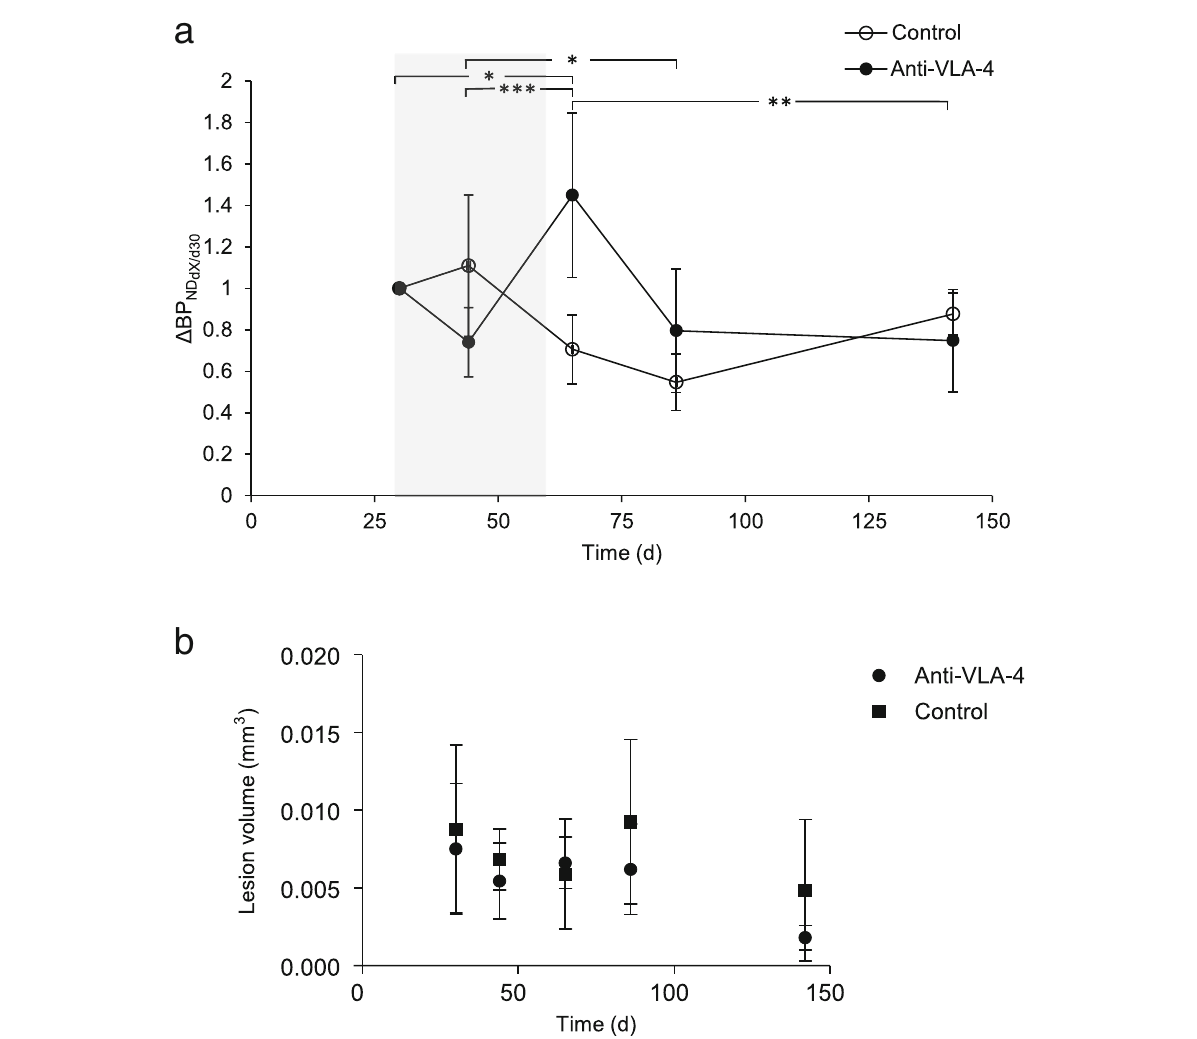
Fig. 3 Cessation of anti-VLA-4 mAb treatment leads to rapid activation of microglia, which can be quantified using in vivo TSPO imaging. a A graph showing BP ND calculated as a function of treatment by subtracting the day 30 BP ND value from the values at the other time points. Treatment was started 30 days after the activation of the lesion, and a baseline PET/CT image was acquired. Animals were treated with subcutaneous injection of an anti-VLA-4 mAb or an isotype-matched non-binding control mAb every third day until day 61. The treatment period is shown as a light grey background. PET/CT images were acquired on days 30, 44, 65, 86 and 142. Statistical analysis indicates the difference in the mean change during the study between the treated and control animals in group A. All data are plotted as means, with the error bars showing SD values. b No changes in lesion volume were detected between treated and control animals. * p <0.05, ** p <0.01, *** p <0.001; BP ND non-displaceable binding potential, CNS central nervous system, CT computer tomography, mAb monoclonal antibody, MRI magnetic resonance imaging, mAb monoclonal antibody, PET positron emission tomography, VLA - 4 very late